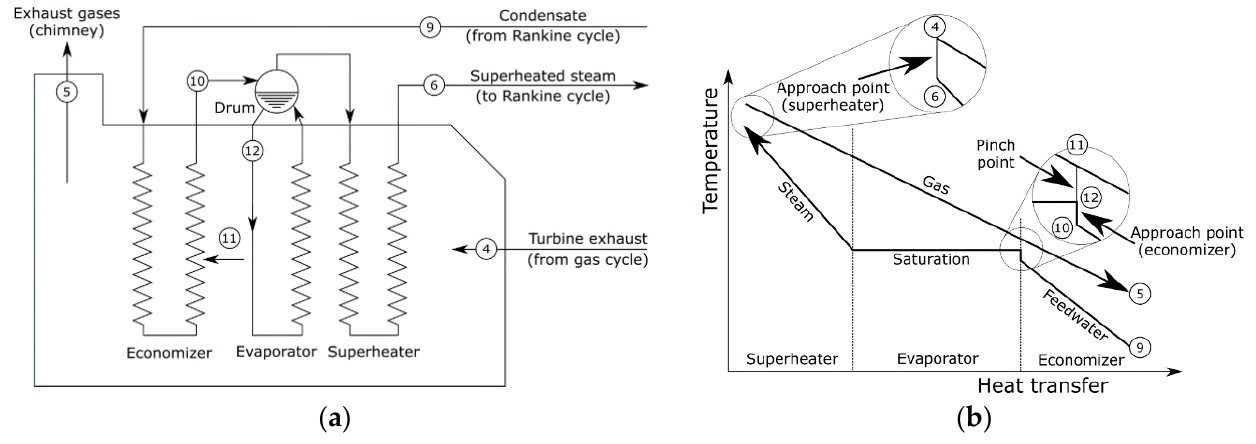
Figure 22. ( a ) Detailed view of a HRSG and ( b ) Temperature—heat transfer diagram.